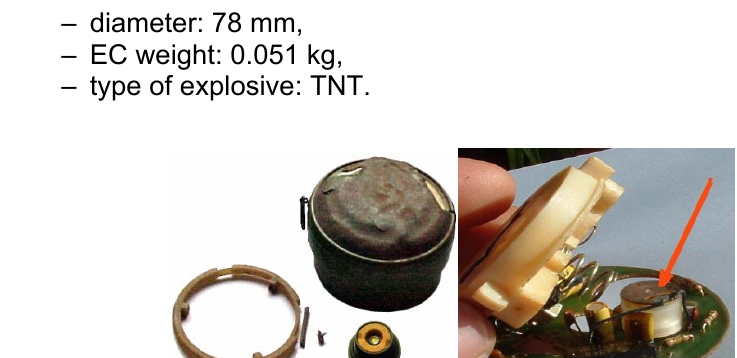
Figure 8 – Type 72 mine Рис . 8 – Мина Тип 72 Слика 8 – Мина Tip 72